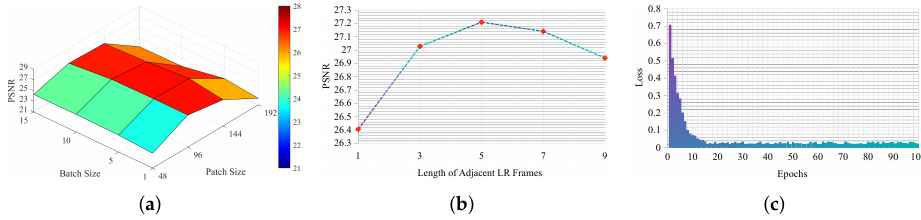
Figure 15. Influence of parameters on the performance of VSSR in the San-ya video. ( a ) Influence of patch size and batch size. ( b ) Influence of the length of adjacent LR frames. ( c ) Influence of epochs during training the